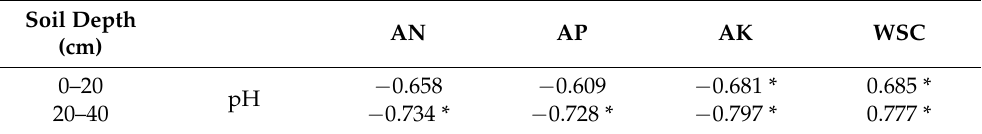
Table 4. Correlations of soil pH value to macronutrients in the three sampling sites. Soil